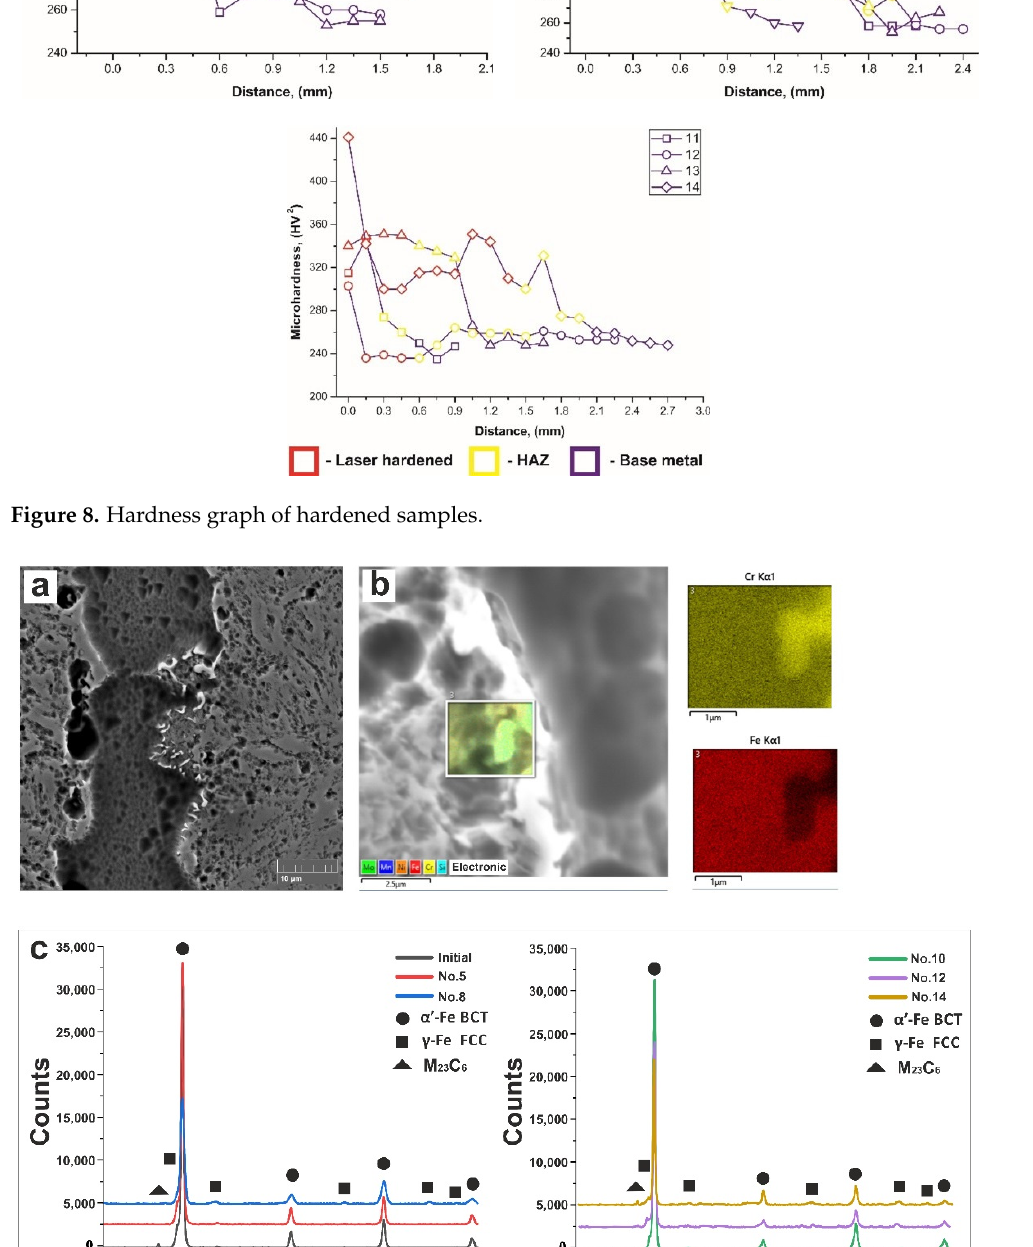
Figure 9. ( a ) SEM micrographs showing M 23 C 6 carbides distributed inside the ferrite matrix. ( b ) SEM-EDX mapping the molar fraction of Cr over the area specified in ( a ). ( c ) X-ray diffraction pat- tern that confirms the crystallographic